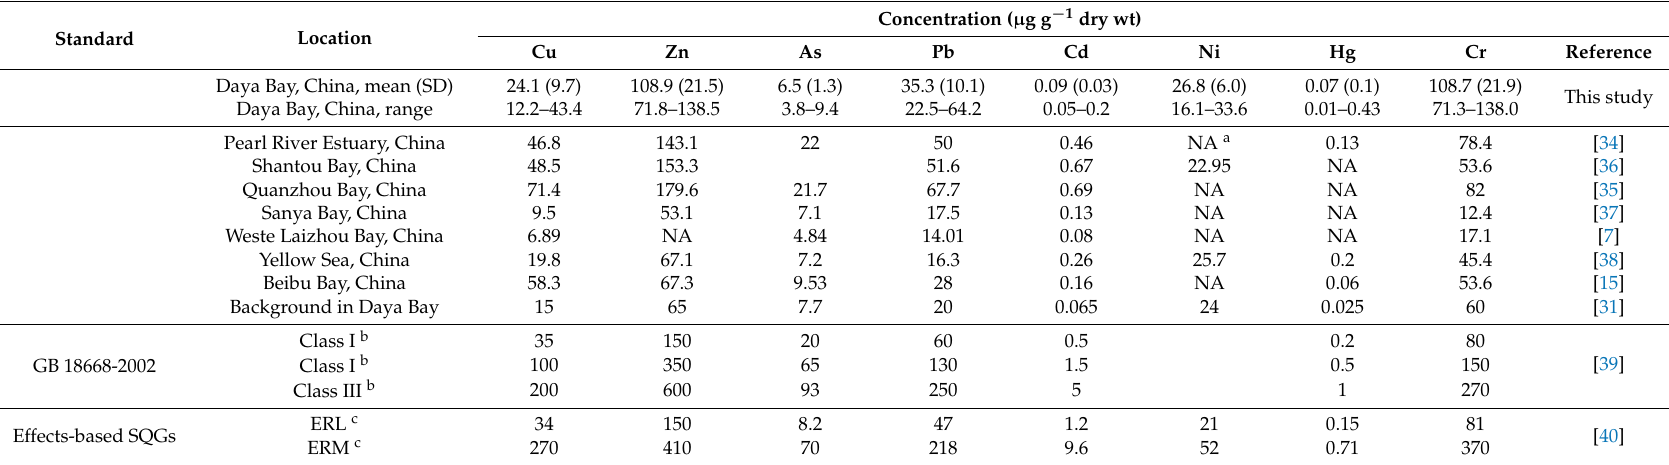
Table 1. Comparison of mean concentrations of heavy metals in the surface sediments of Daya Bay and other coastal areas, sediment quality guidelines (SQGs) of China, and effects-based SQGs of